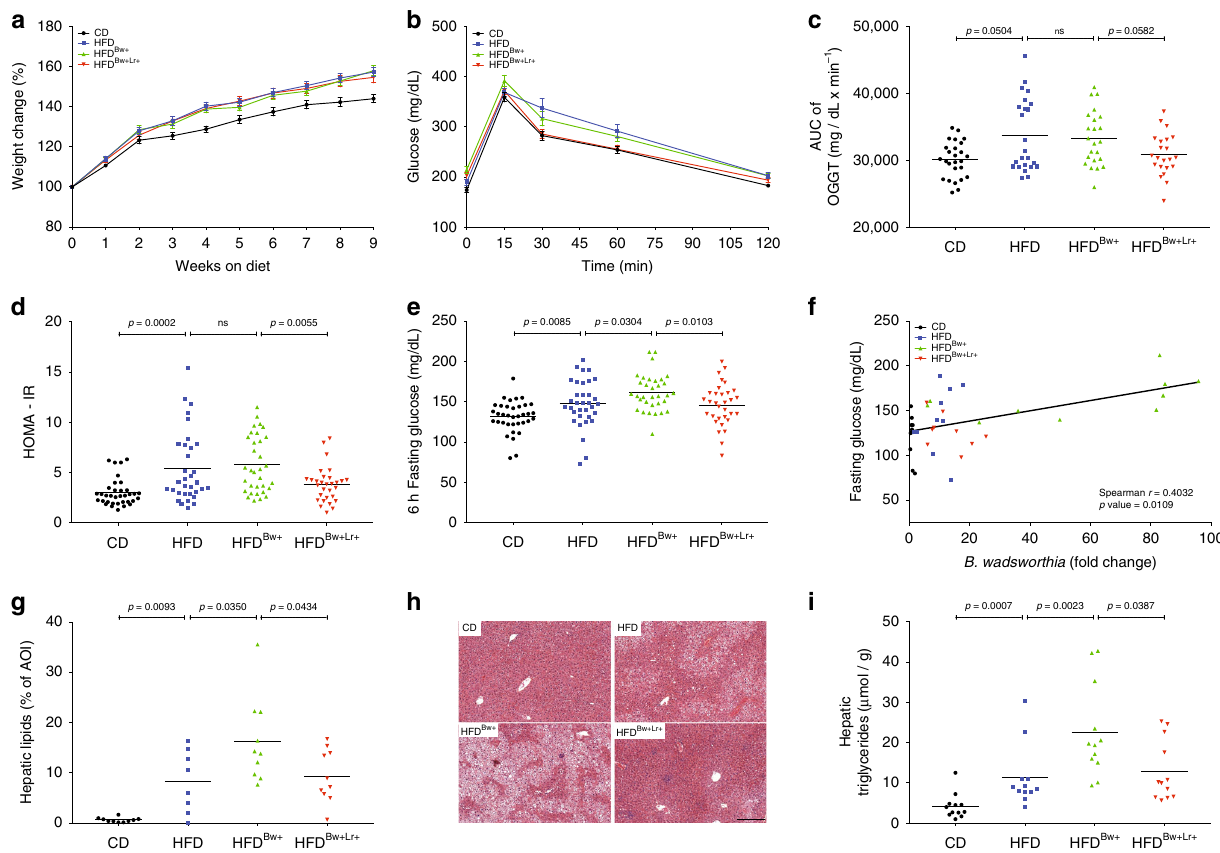
Fig. 2 B. wadsworthia synergizes with HFD to trigger a stronger metabolic impairments. a Body weight gain ( n = 37 – 40/group). b Blood glucose level before and after oral glucose tolerance challenge (OGTT; 2 g/kg mouse; n = 27 – 40/group). c Area under the curve (AUC) of OGTT. d homeostatic model assessment-insulin resistance (HOMA-IR) after 6 h of fasting. e Blood glucose after 6 h of fasting. f Spearman correlation of fasting glucose and B. wadsworthia load in the cecal content. g Lipid area, calculated as % area of interest (AOI), in liver cross-sections stained with H&E. h Representative pictures of liver stained with H&E. Scale bar = 100 µ m. i Liver triglycerides after 6 h of food deprivation. Statistical comparison was performed by fi rst testing normality using Kolmogorov – Smirnov test and then ANOVA or Kruskal – Wallis test with Bonferroni or Dunn ’ s post hoc test. Error bars represents